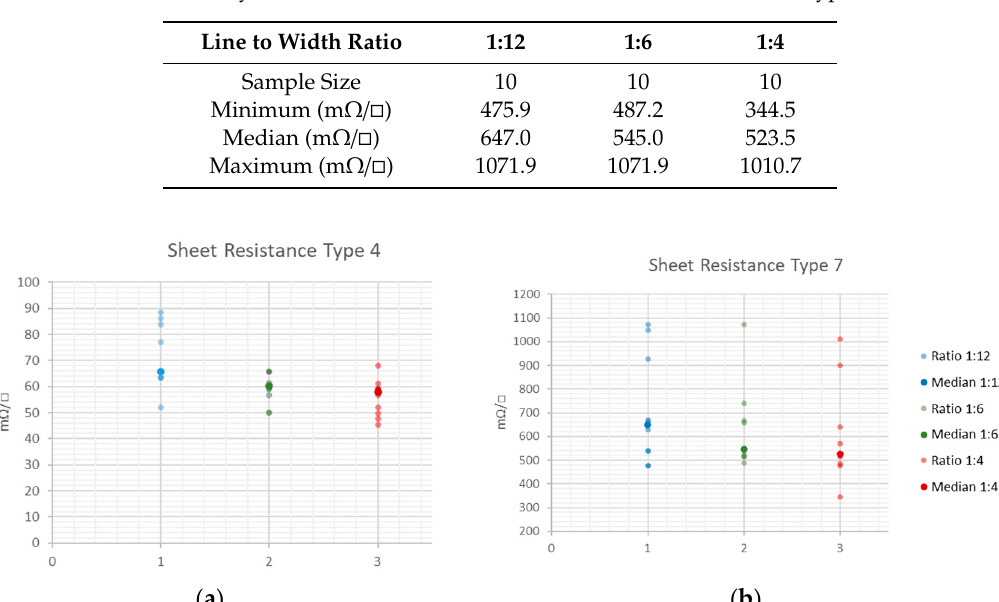
Table 3. Statistical key data of the sheet resistance measurement values for the type 4 substrate. Line to Width Ratio